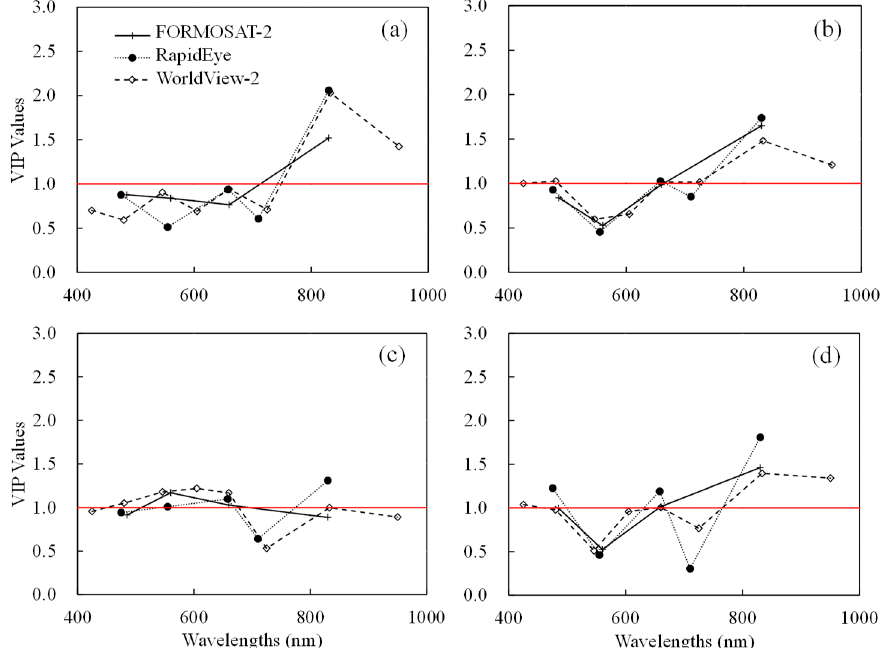
Figure 5. Variable Importance in Projection (VIP) values as function of wavelengths formatted to FORMOSAT-2, RapidEye, and WorldView-2 spectra for plant N uptake (PNU) estimation at: the panicle initiation (PI) ( a ); stem elongation (SE) ( b ); heading (HE) ( c ); and across stages ( d ).